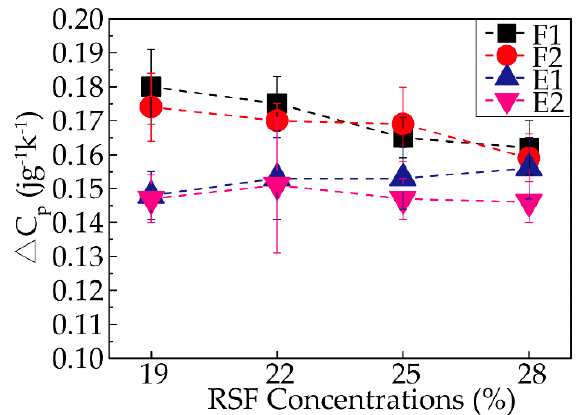
Figure 9. Variations in the heat capacities ( △ c p ) of all the RSF samples.